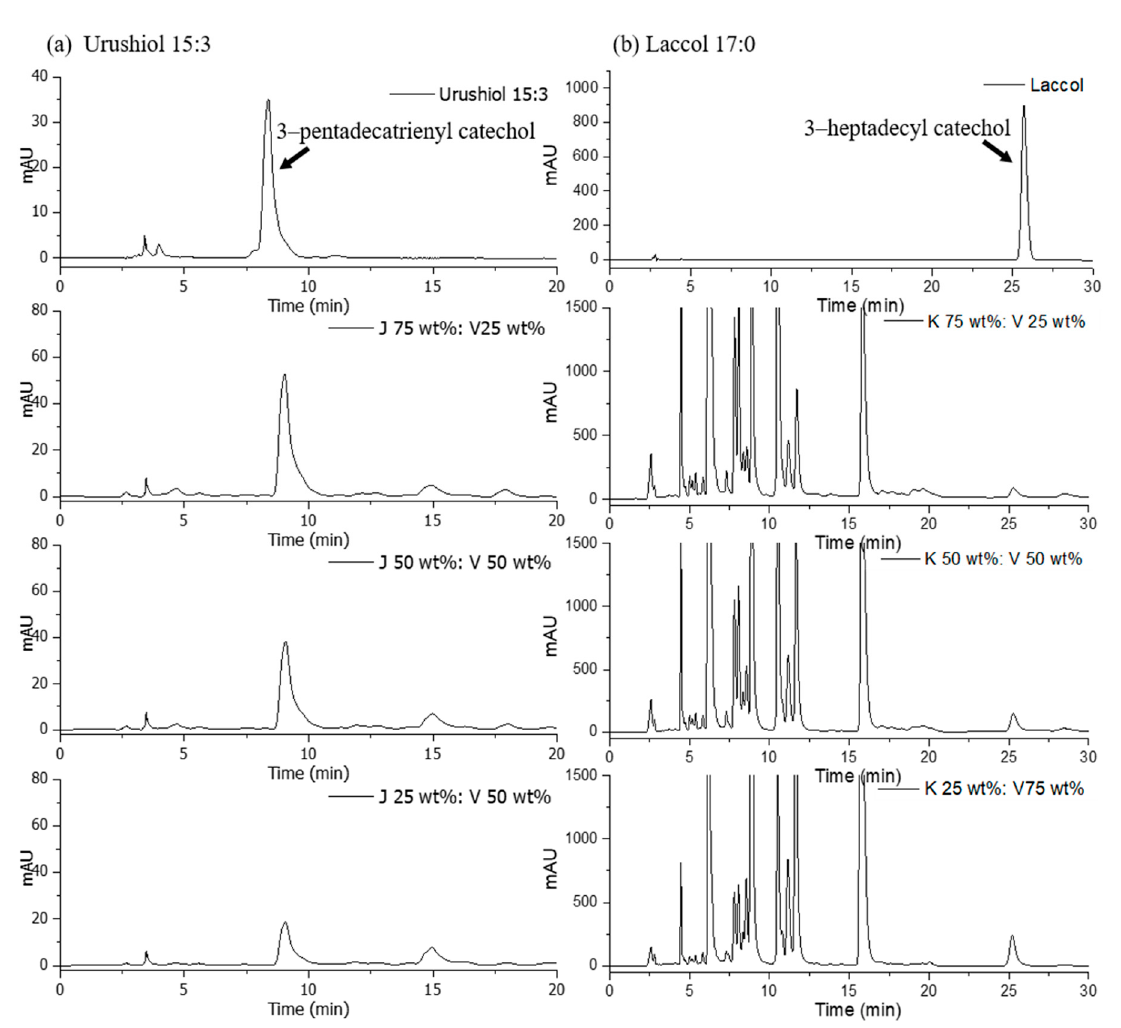
Figure 5. HPLC chromatograms of blended Japanese and Vietnamese lacquers including the following catechols: ( a ) 3-pentadecatrienyl; ( b ) 3-heptadecyl.